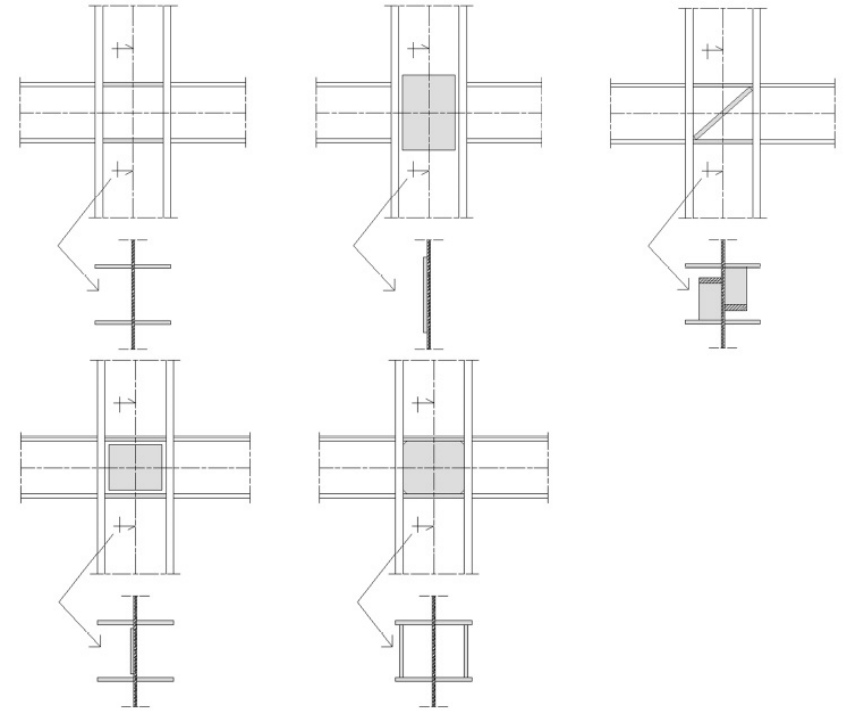
Figure 10. Web panels reinforcement options.